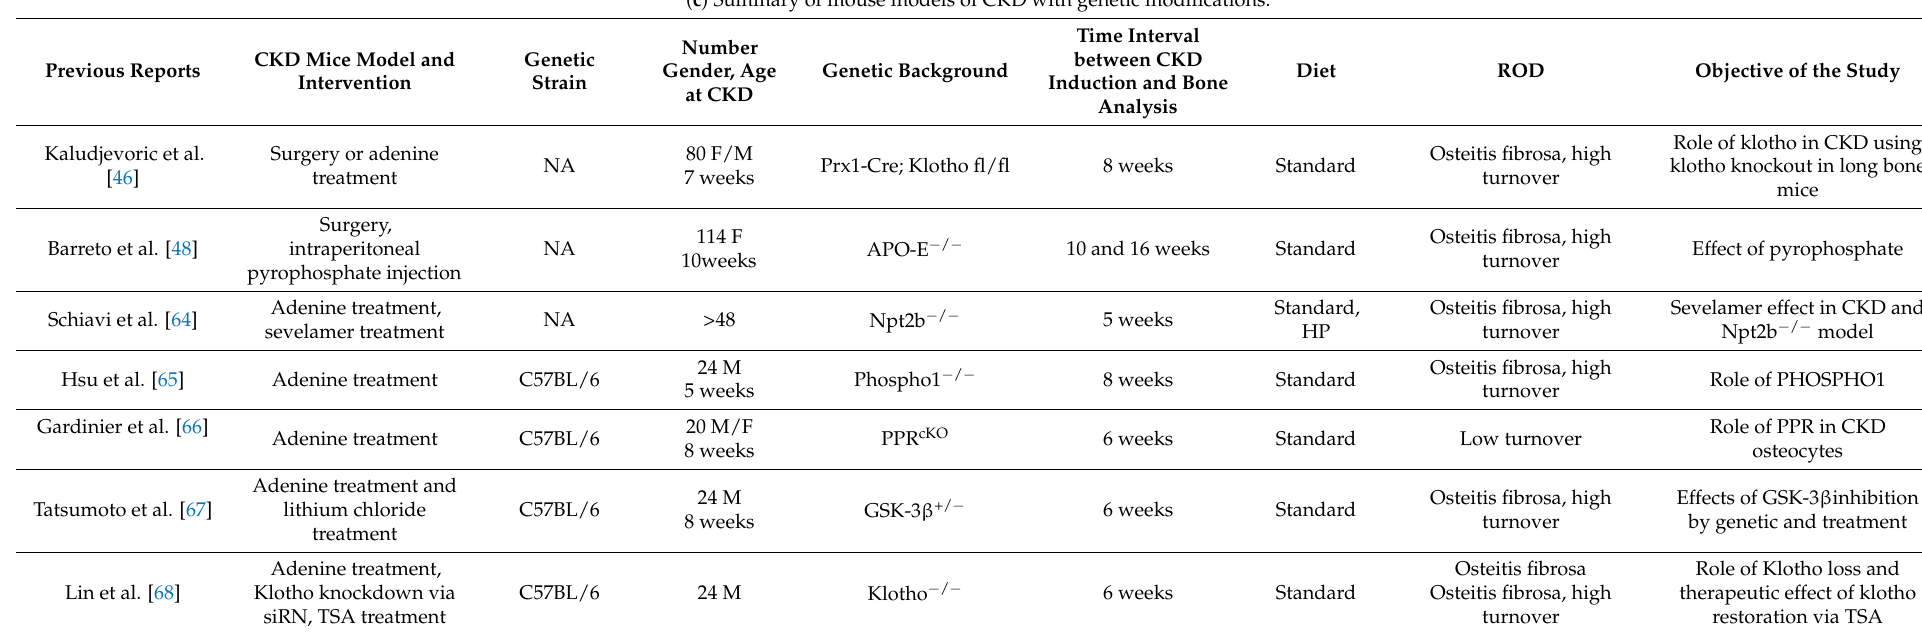
Table 1. Cont. ( c ) Summary of mouse models of CKD with genetic